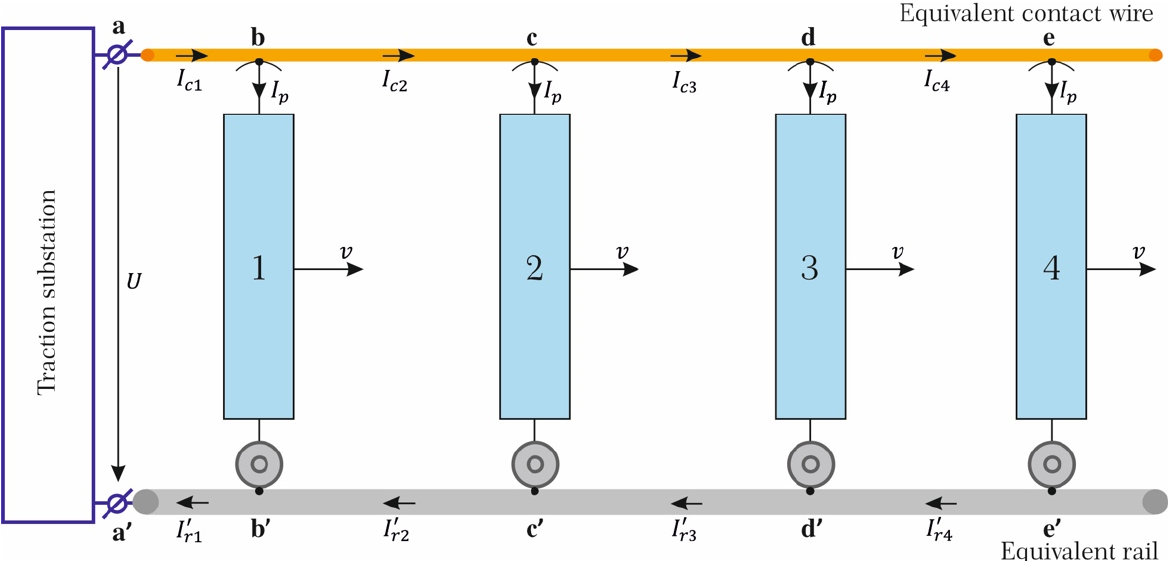
Figure 1. Schematic representation of the AC inter-substation zone with one-sided power supply and four trains driven by DS3 locomotives.